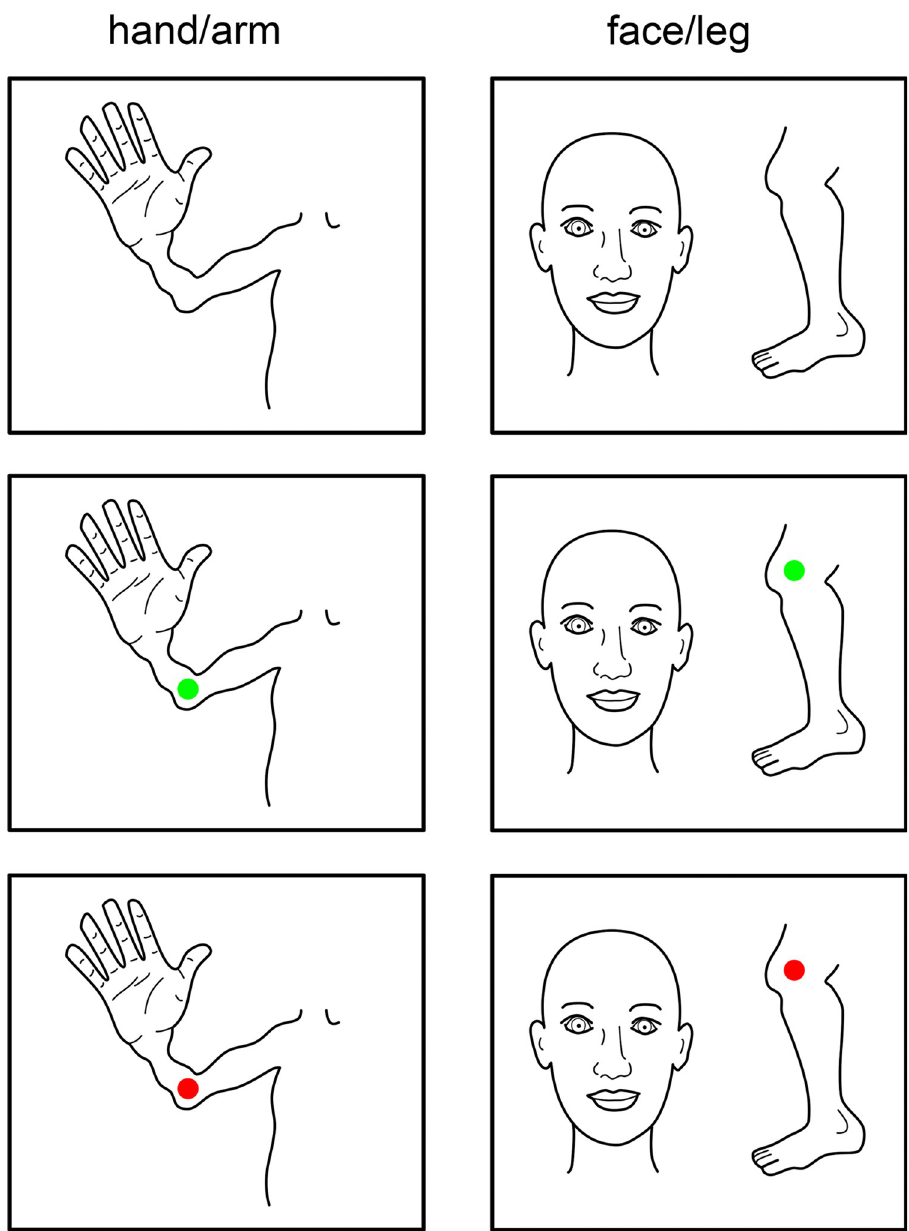
Fig 9. Scanner instructions. Top row shows the images presented throughout the task for the hand/arm/torso run (left) and face/leg-run (right). Middle and bottom rows show examples of the flexion-extension cues for the elbow (left) and knee